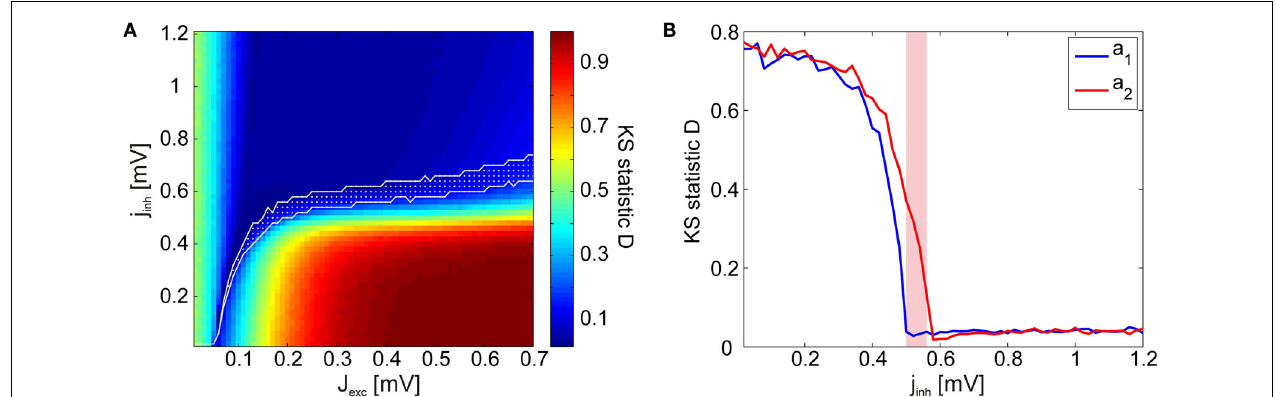
FIGURE 5 | KS statistic as a measure of criticality. (A) KS statistic D of the avalanche size distributions in the reduced network, averaged over all stimulus presentations. Visual inspections reveal that the avalanche size distributions P ( s ) are characteristically subcritical (exponential) for most points in the coupling space with low D -values. The transition region